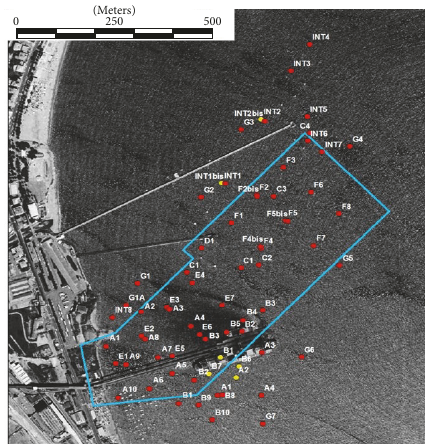
Figure 3: Sampling points (red dots = more than 70% of chemicals exceed limits, yellow dots = less than 70% of chemicals exceed limits, and blue line = new